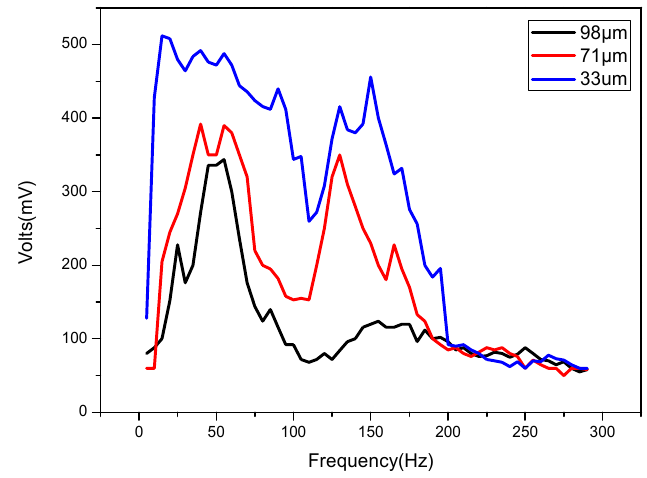
Figure 5. The detecting electrical signal versus different fiber diameters. To confirm that this FBG hydrophone has the ability to detect high-frequency acoustic waves, the experimental setup used to detect acoustic waves with the FBG hydrophone, except for the signal generator, amplifier, loudspeaker, and water tank, was moved to the Underwater Acoustic Laboratory of the Department of Marine Engineering of Taiwan University to measure acoustic waves in the frequency range from 4 to 10 kHz. The Underwater Acoustic Laboratory has the most standard measurement facility for detecting acoustic waves under water, including a signal processor, an amplifier, a conventional standard hydrophone, an acoustic wave source, and a large water pool with length of 120 m, width of 8 m, and depth of 4 m, as shown in Figure 6. This conventional standard hydrophone is based on a piezoelectric transducer, transferring the detected acoustic waves to the voltage signal in the high-frequency band to be shown in an oscilloscope. The FBG hydrophone is based on the photodetector, which converts the optical signal into the electrical signal to be shown in an oscilloscope. The experimental results of both the FBG hydrophone and the standard hydrophone can be compared to determine which kind of hydrophone demonstrates better sensing performance.